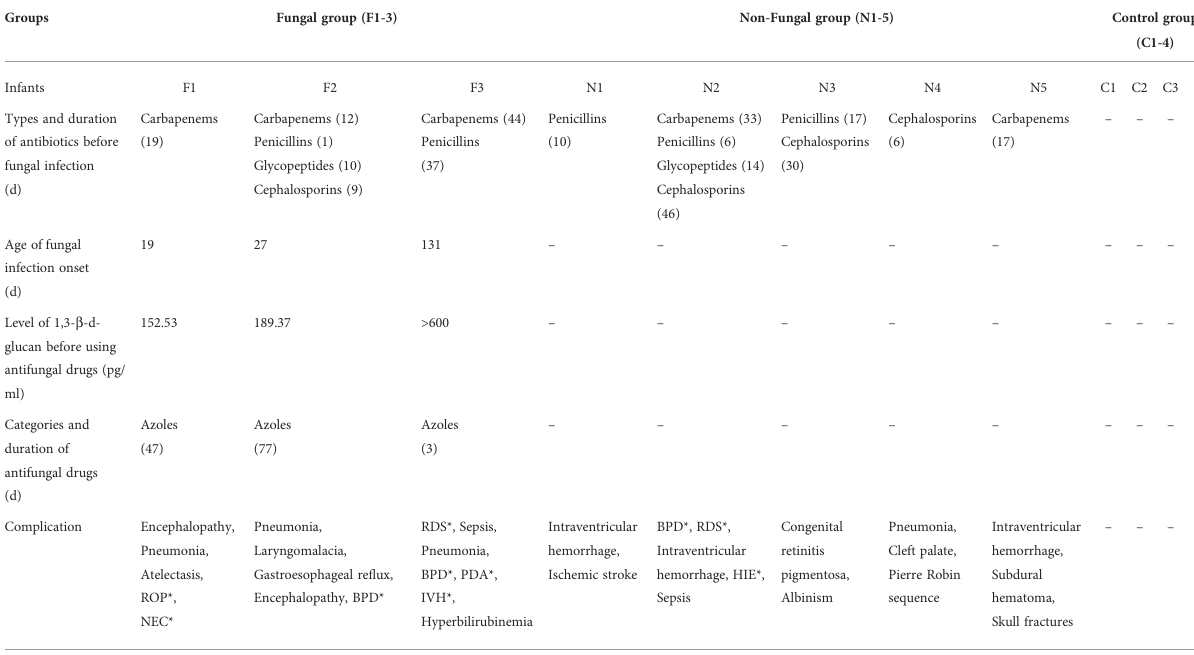
TABLE 2 Clinical and laboratory information among the three groups of individuals